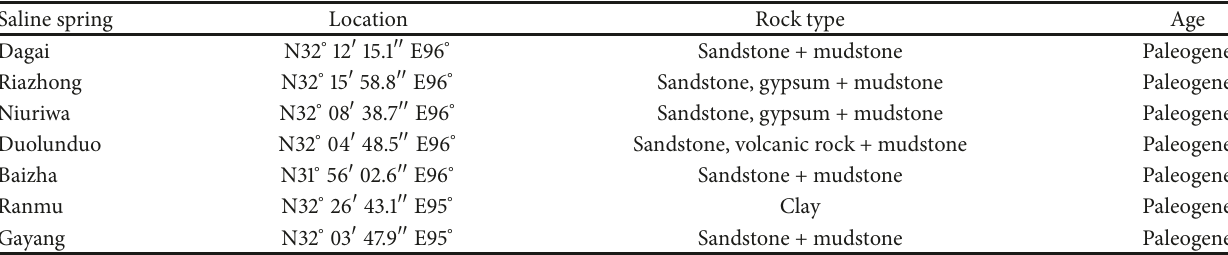
Table 1: Sampling